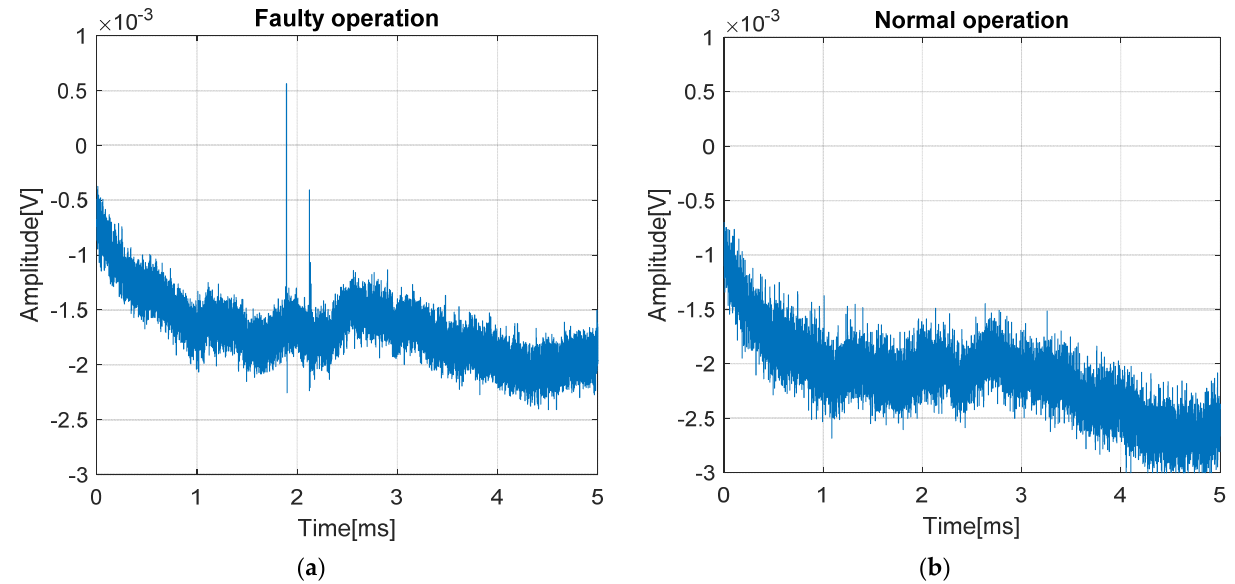
Figure 7. ( a ) Faulty operation of the system; ( b ) normal operation of the system.